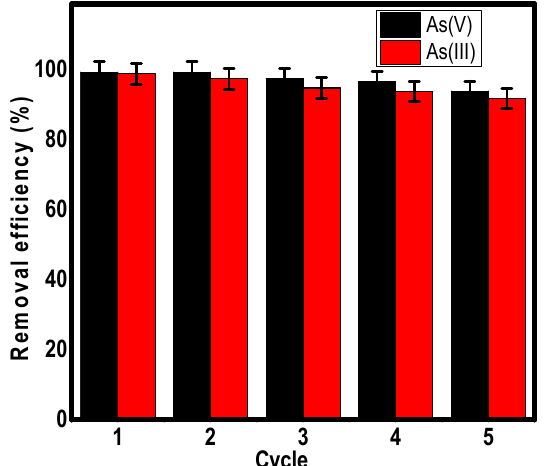
Figure 8. The reusability of Fe 3 O 4 /CS/PEI magnetic nanomaterials for the removal of As(V) and As(III) ions up to five successive cycles.